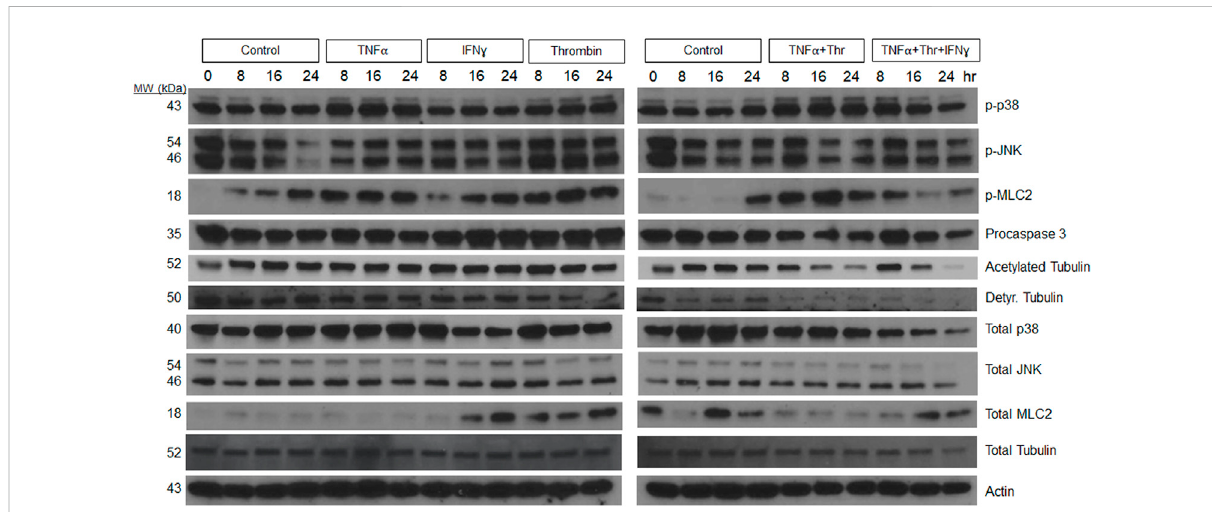
FIGURE 4 Signaling events de fi ning lymphatic EC tube regression following exposure to TNF (tumor necrosis factor) α , IFN (interferon) γ , and thrombin (Thr).Lymphaticendothelial cell(LEC)lysateswerepreparedfrom3-dimensional(3D)culturesat72 h(i.e.after24 hofexposuretoindividual factors or combinations of TNF α 10 ng/ml, IFN γ 10 ng/ml or Thr 1 μ g/ml vs. controls). Western blots were performed and probed with the indicated antibodies including phosphorylation site targets and their control proteins. Phospho-p38 (phosphorylated p38 mitogen-activated protein kinase), phospho-JNK (phosphorylated Jun kinase), phospho-MLC2 (phosphorylated myosin light chain 2), Detyr. Tubulin (detyrosinated